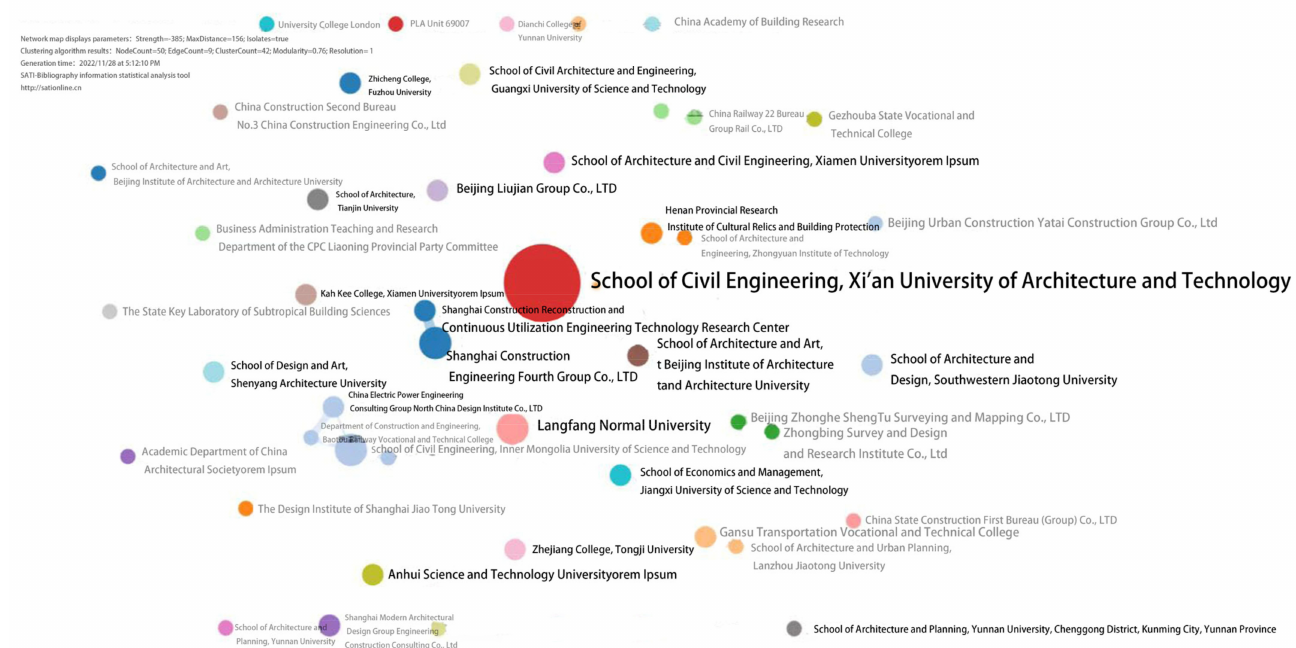
Figure 9. China BIM and architectural heritage research institution cooperation